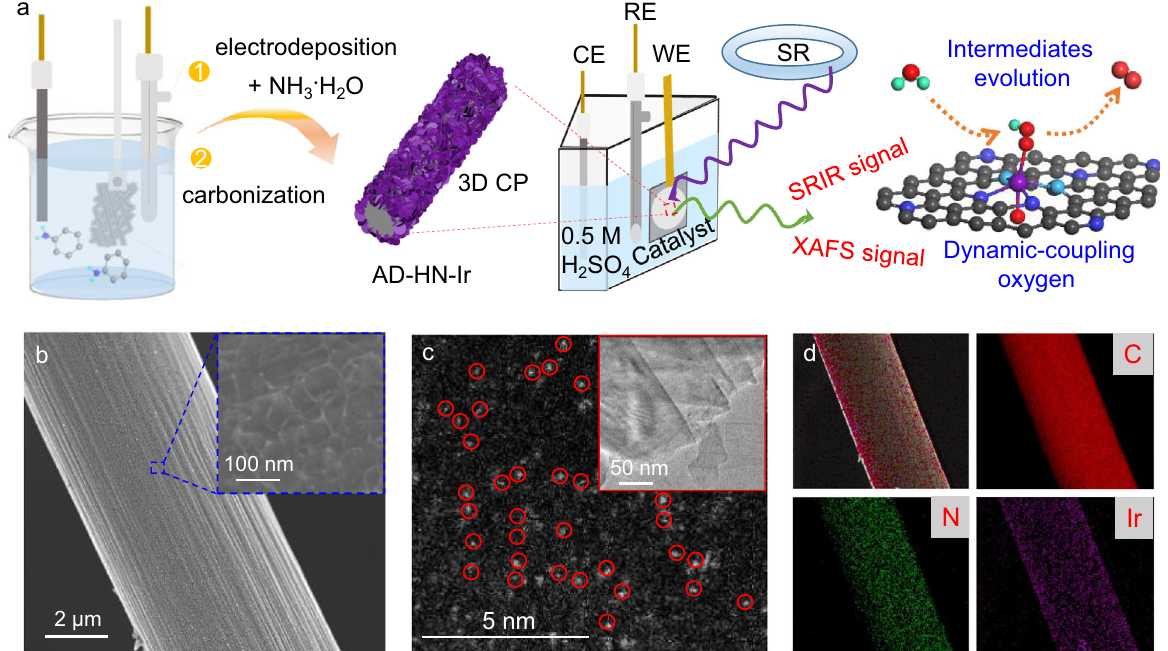
Fig. 1 In situ electrochemical measurement and structural characterizations of AD – HN – Ir electrocatalyst. a Scheme of the synthetic process. CE counter electrode, WE, working electrode, RE reference electrode, CP carbon paper, SR synchrotron radiation, C black, N 1 royal blue, N 2 indigo, O red, H green, Ir purple. b SEM image of AD – HN – Ir electrocatalyst, and the inset is a partially enlarged image. c HAADF-TEM image and the inset is a TEM image. d STEM- EDS mapping images for AD – HN – Ir